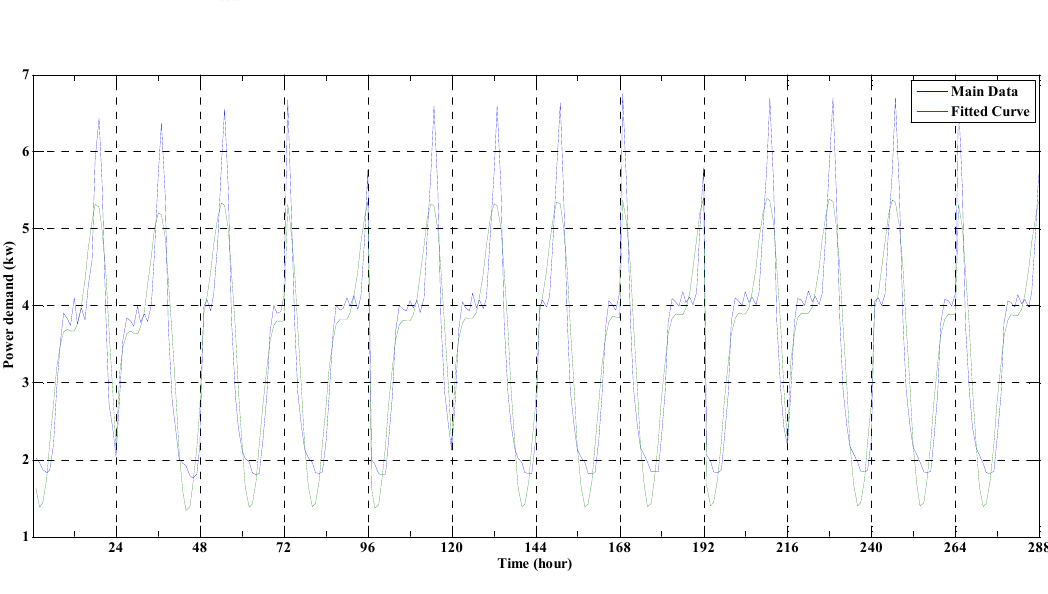
Figure 3. Monthly average diurnal demand patterns exploited.